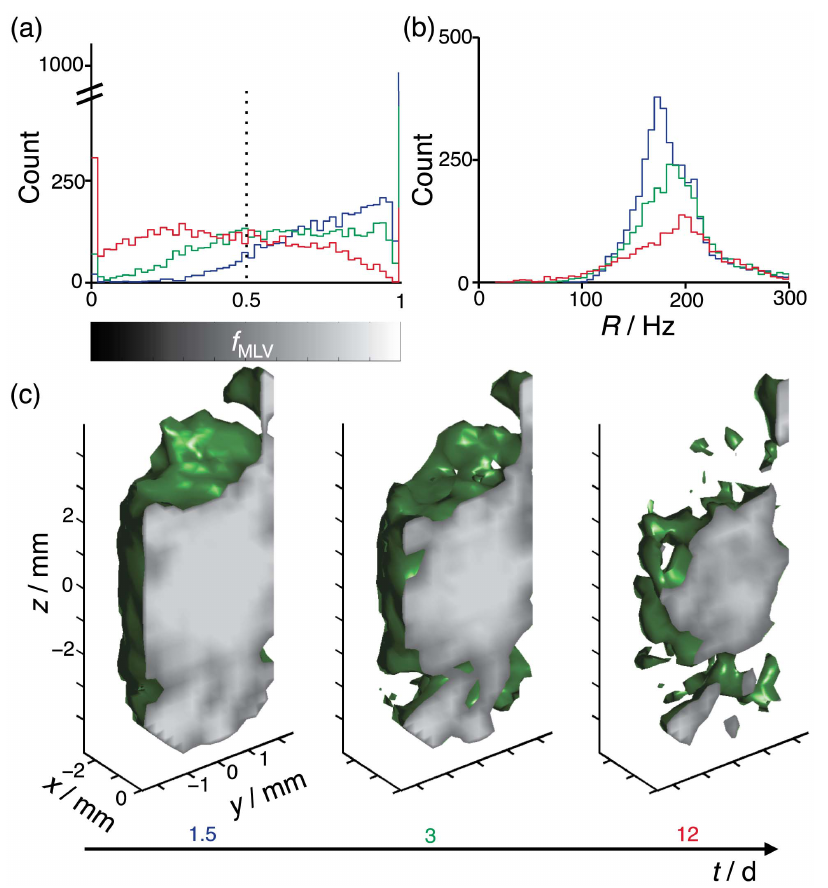
Figure 6. Time-resolved 3D mapping of the breakdown of MLVs to other lamellar morphologies. Spectral deconvolution of spatially resolved 2 H NMR spectra gives estimates of the fraction of MLVs f MLV and peak width R of the MLV singlet. Histograms of f MLV and R are shown in panels (a) and (b), respectively, for the times t =1.5 (blue), 3 (green) and 12 (red) days after MLV preparation. The dashed line in (a) indicates the value used for separating between voxels dominated by MLVs ( f MLV w 0 : 5 ) or other lamellar morphologies ( f MLV v 0 : 5 ). The counts in (b) are weighted by the values of f MLV . (c) 3D rendering of the contour f MLV ~ 0 : 5 (green surface) at the times t =1.5, 3 and 12 days. The surface at x ~ 0 represents f MLV with gray scale given by the bar on the f MLV -axis in panel (a).